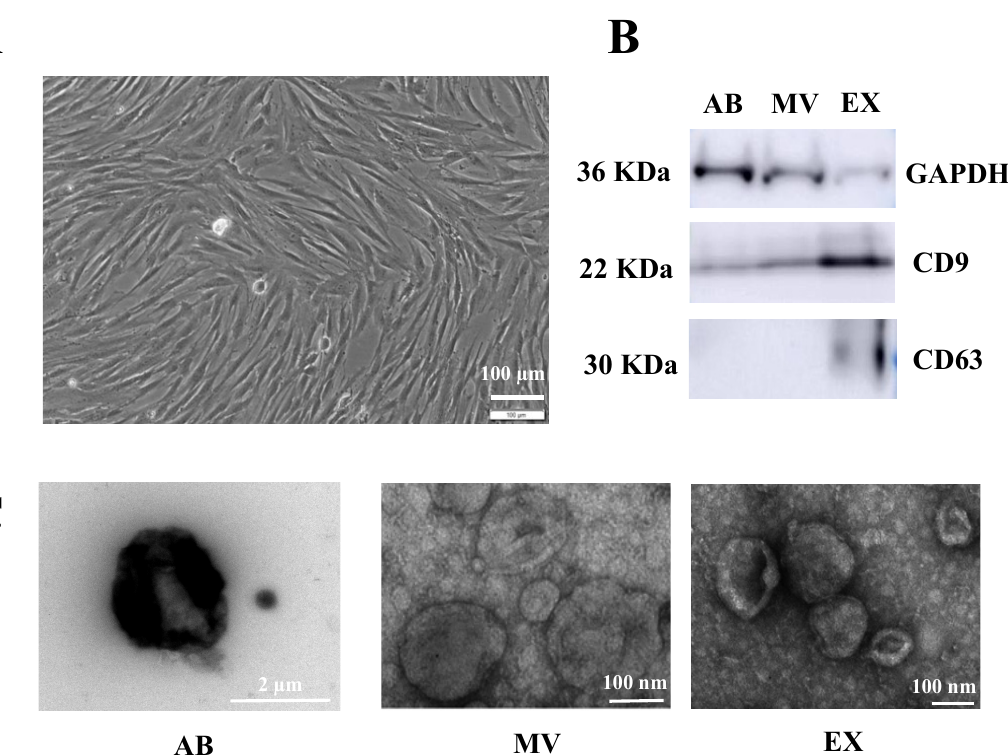
Figure 1. Characteristics of EVs secreted by TGF β -stimulated UCMSCs. ( A ) Morphology of TGF β - stimulated UCMSCs. ( B ) Marker expression of EVs: GAPDH and CD9 were detected in all AB, MV, and EX; CD63 was detected in only EX. ( C ) Morphology of EVs under TEM analysis. AB: Apoptotic body, MV: Microvesicle, EX: Exosome.